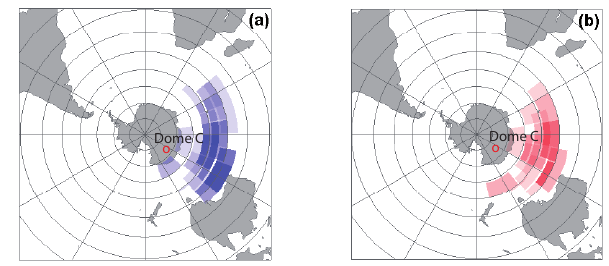
Figure 10. Estimated moisture source areas for arrival levels (a) 600hPa and (b) 500hPa. Stronger color corresponds to higher frequency of occurrence of the respective moisture